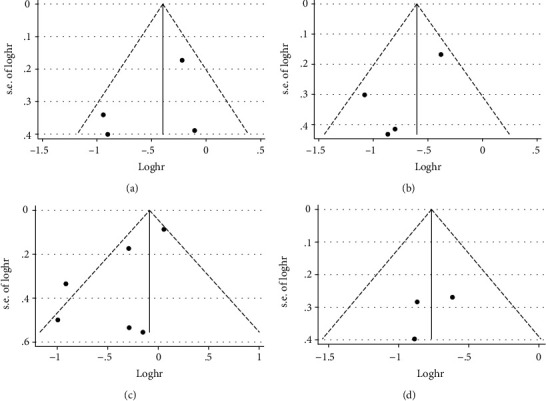
Funnel plot of OS for publication bias. (a) Funnel plot for PER1 protein expression and OS. (b) Funnel plot for PER2 protein expression and OS. (c) Funnel plot for PER2 mRNA expression and OS. (d) Funnel plot for PER3 protein expression and OS.